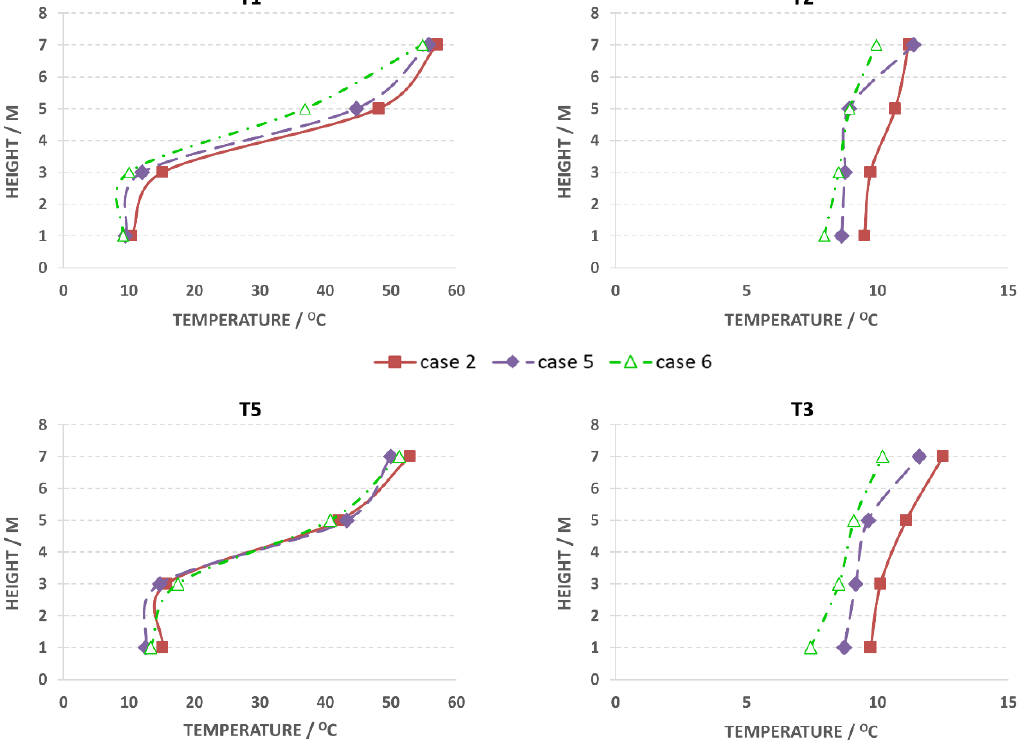
Figure 13. Temperature measurements at thermocouple tree T1, T2, T3, and T5 for Case 2, 5, and 6 .